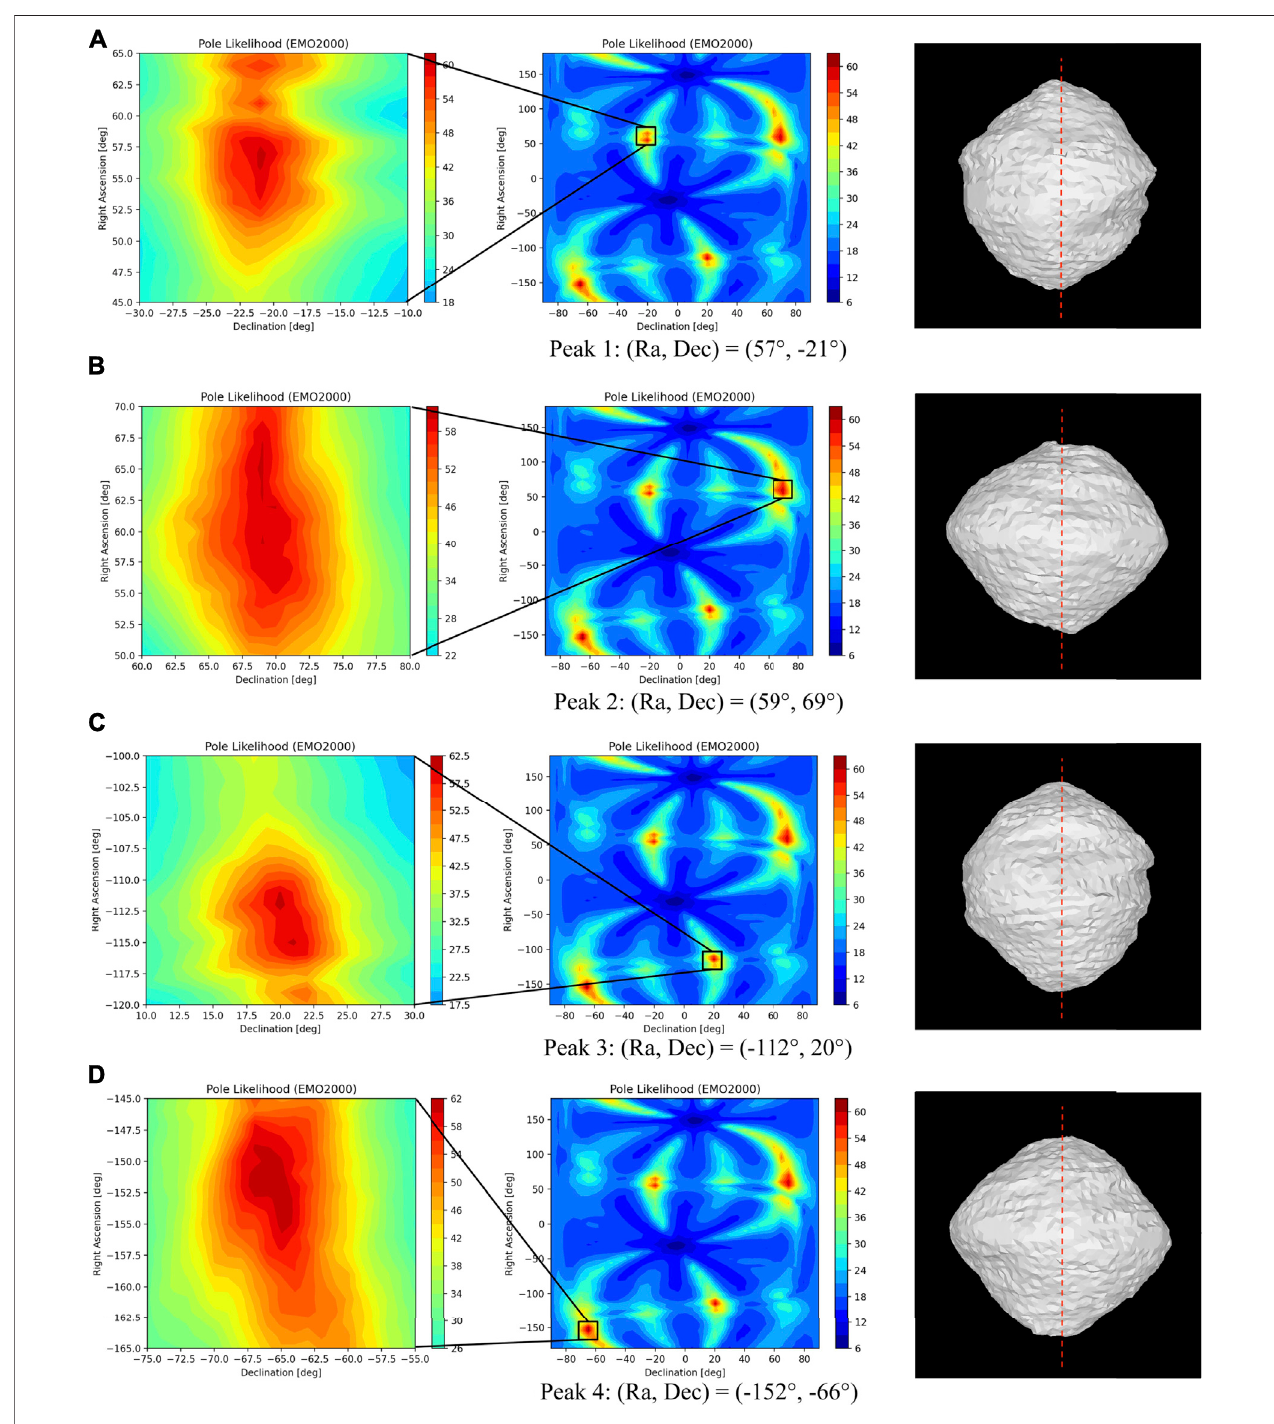
FIGURE 11 | Pole-from-silhouette (PfS)/shape-from-silhouette (SfS) pole and shape estimation using image set 7.